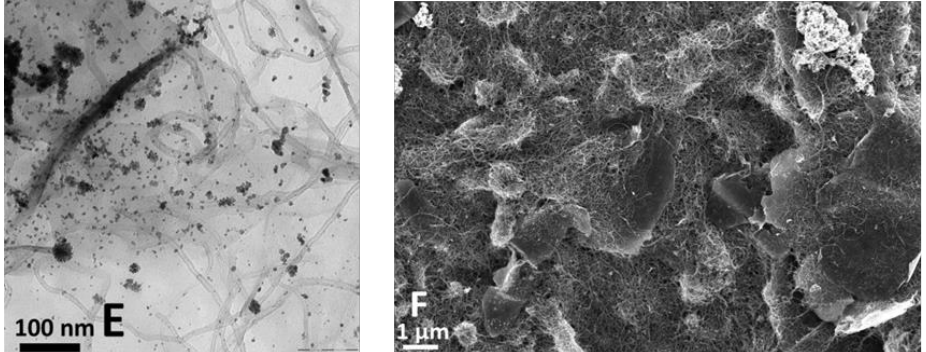
Figure 1. Transmission electron microscopy (TEM) and scanning electron microscopic (SEM) images of ( A , B ) Pt / rGO, ( C , D ), Ir / CNT and ( E , F ) Pt / rGO + Ir / CNT(2:1). Histograms ( A’ ) and ( C’ ) display distribution of sizes of Pt and Ir nanoparticles.